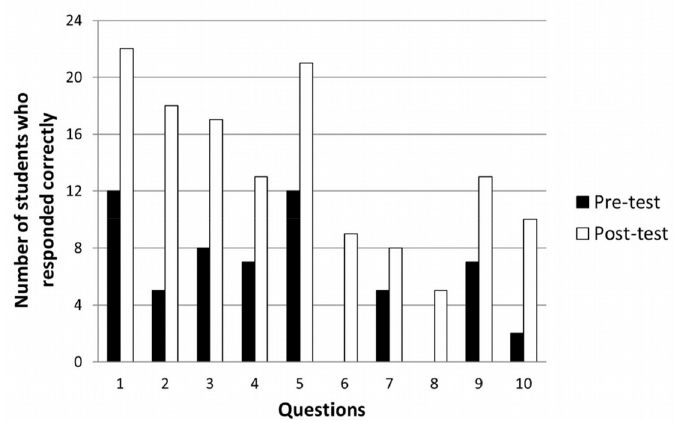
Figure 2. Comparison of the correct answers given by the students in the initial and final evaluation (pre-test vs.